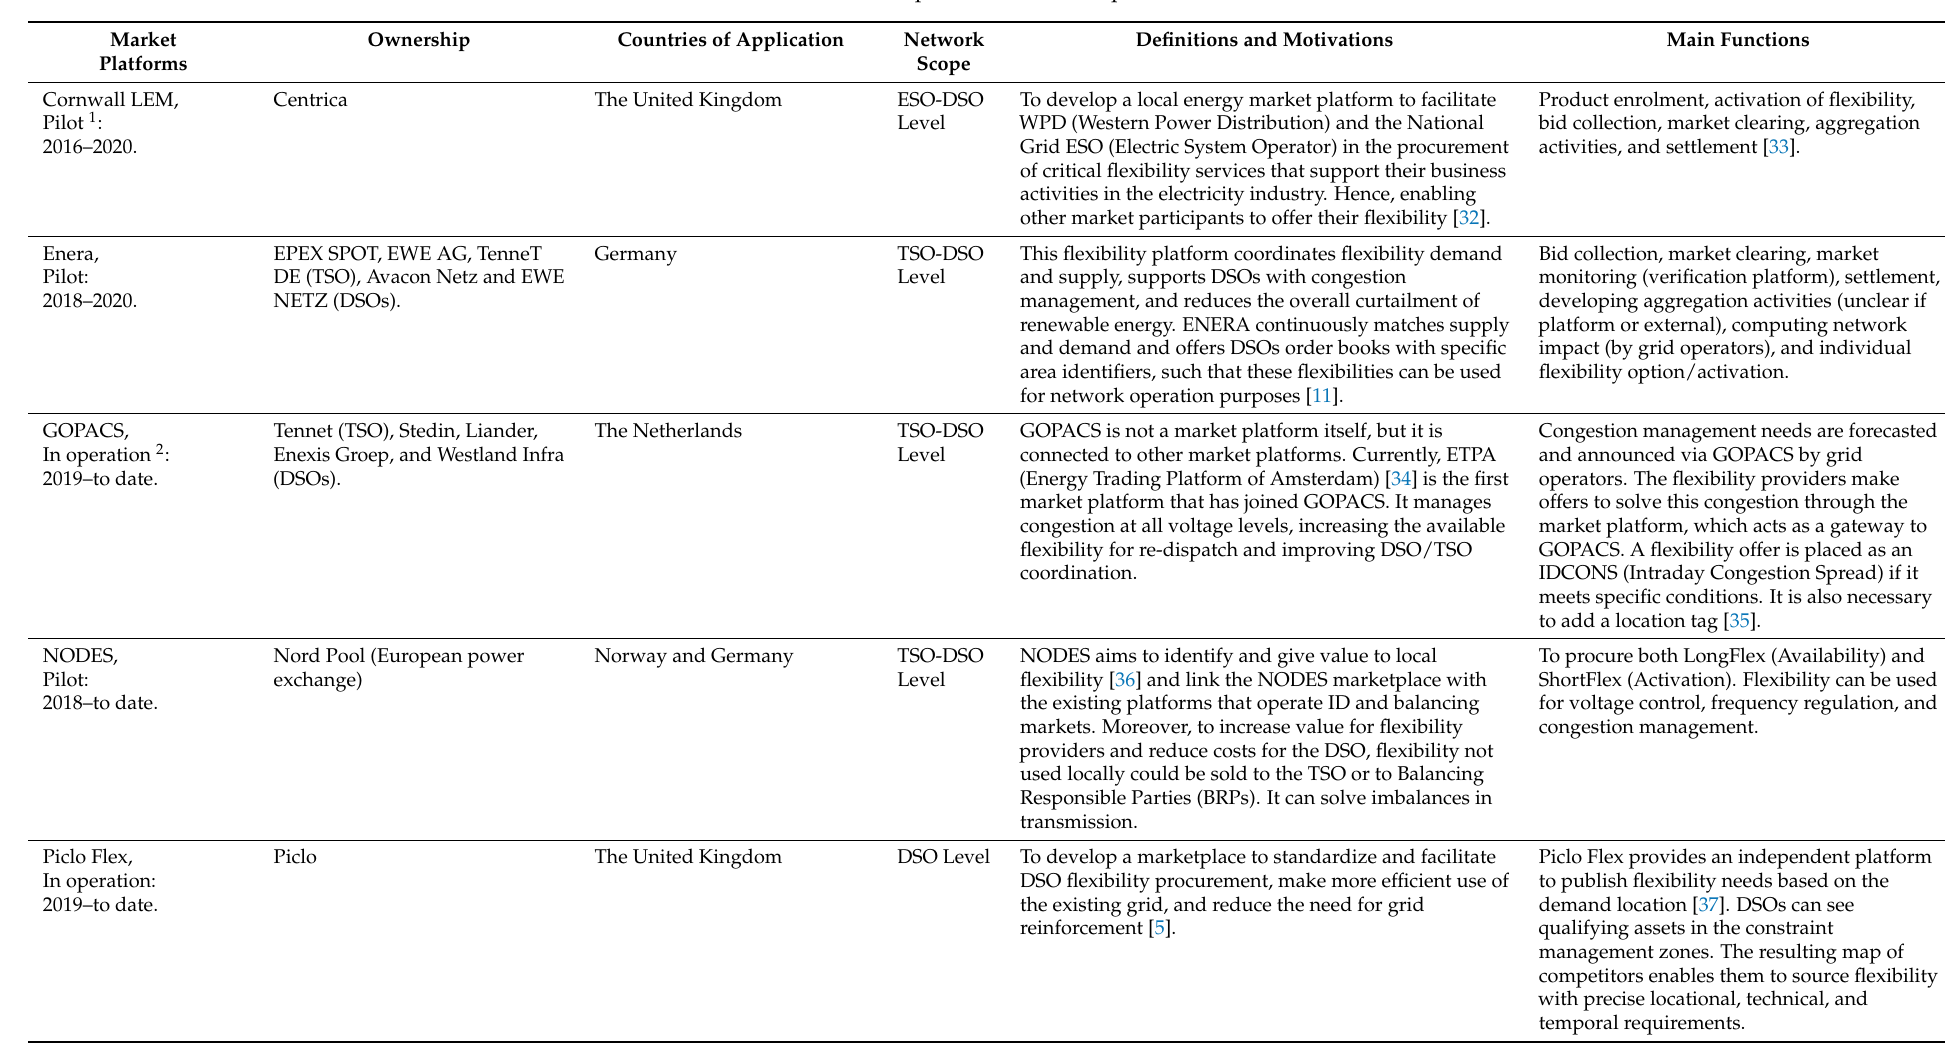
Table 1. Description of the market